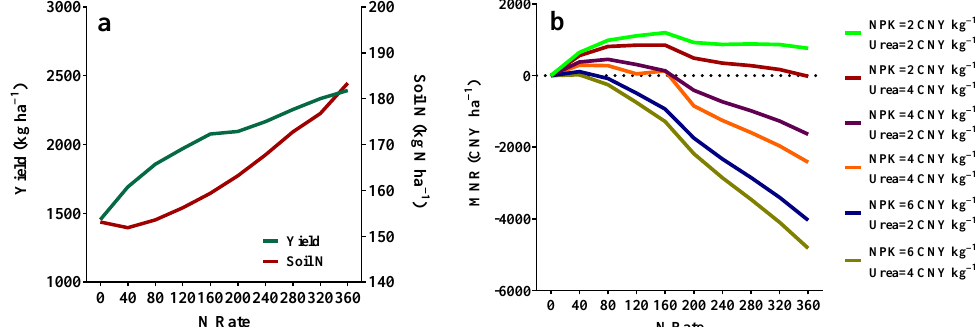
Figure 6. Simulated yield and soil N under different N rates ( a ) and marginal net return (MNR) under different nitrogen rates and N fertilizer prices ( b ) over 30 seasons (the normal price was NPK